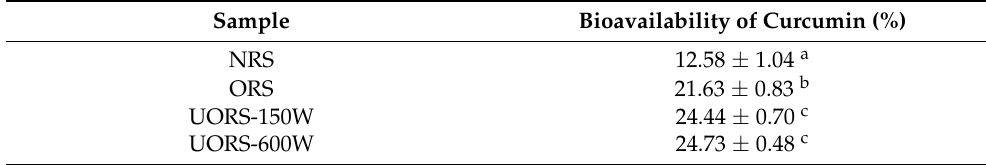
Table 2. The bioavailability of curcumin in emulsions stabilized by native rice starch and OSA rice starch.